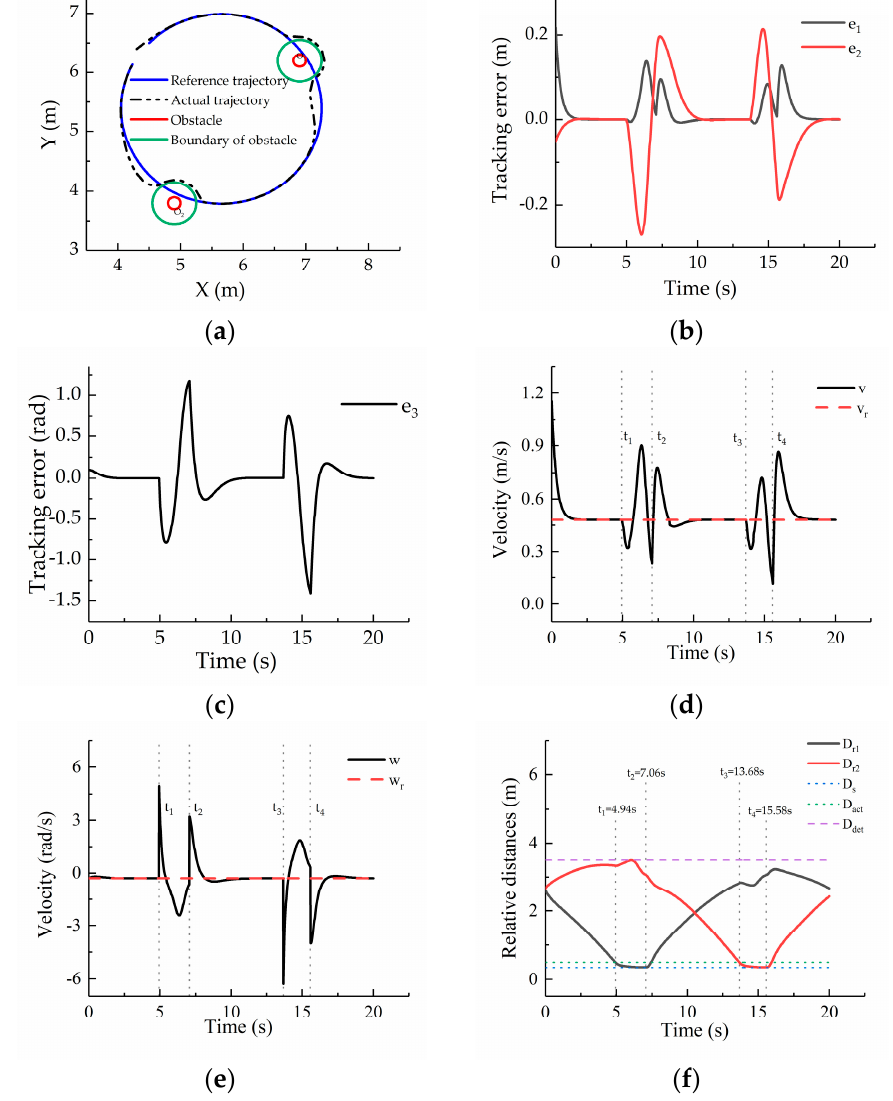
Figure 6. Simulation results of the second example: ( a ) trajectory tracking and obstacle avoidance results; ( b ) position tracking error; ( c ) angular tracking error; ( d ) control input v and reference velocity v r ; ( e ) control input ω and reference velocity ω r ; ( f ) relative distances between the robot and obstacles.